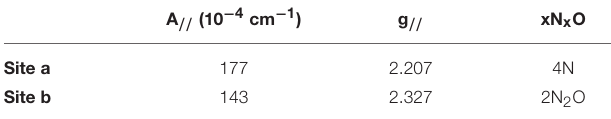
TABLE 1 | EPR parameters for the two binding sites of Cu 2 + in